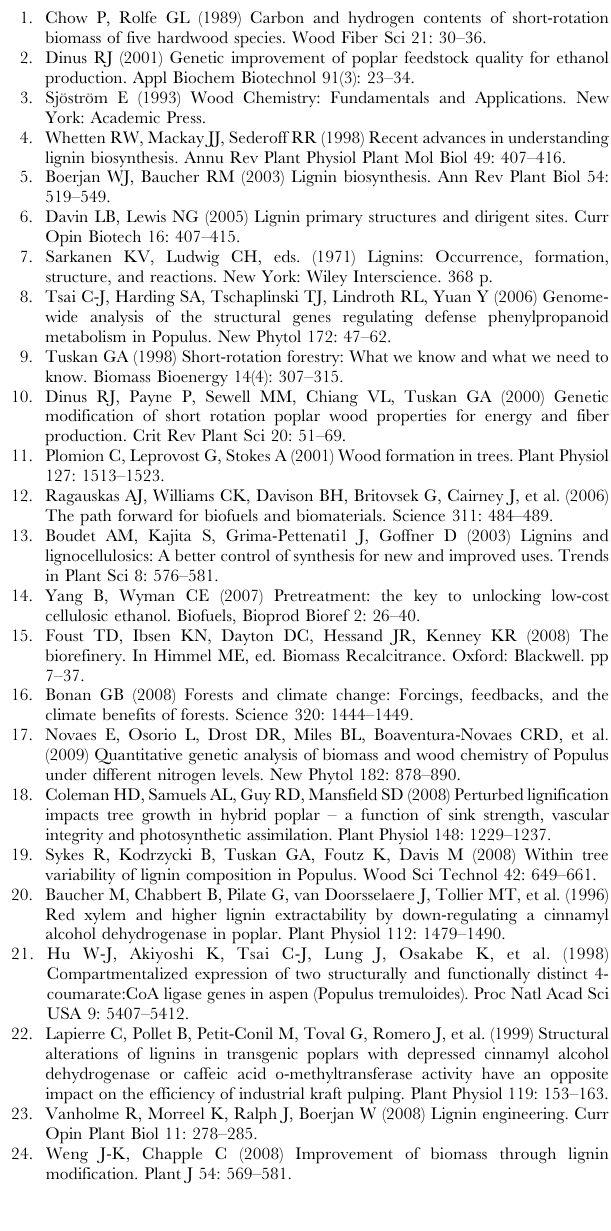
Table S3 Descriptive metrics for the detected QTLs underlying cell wall subcomponents in stem and root in Family 331.